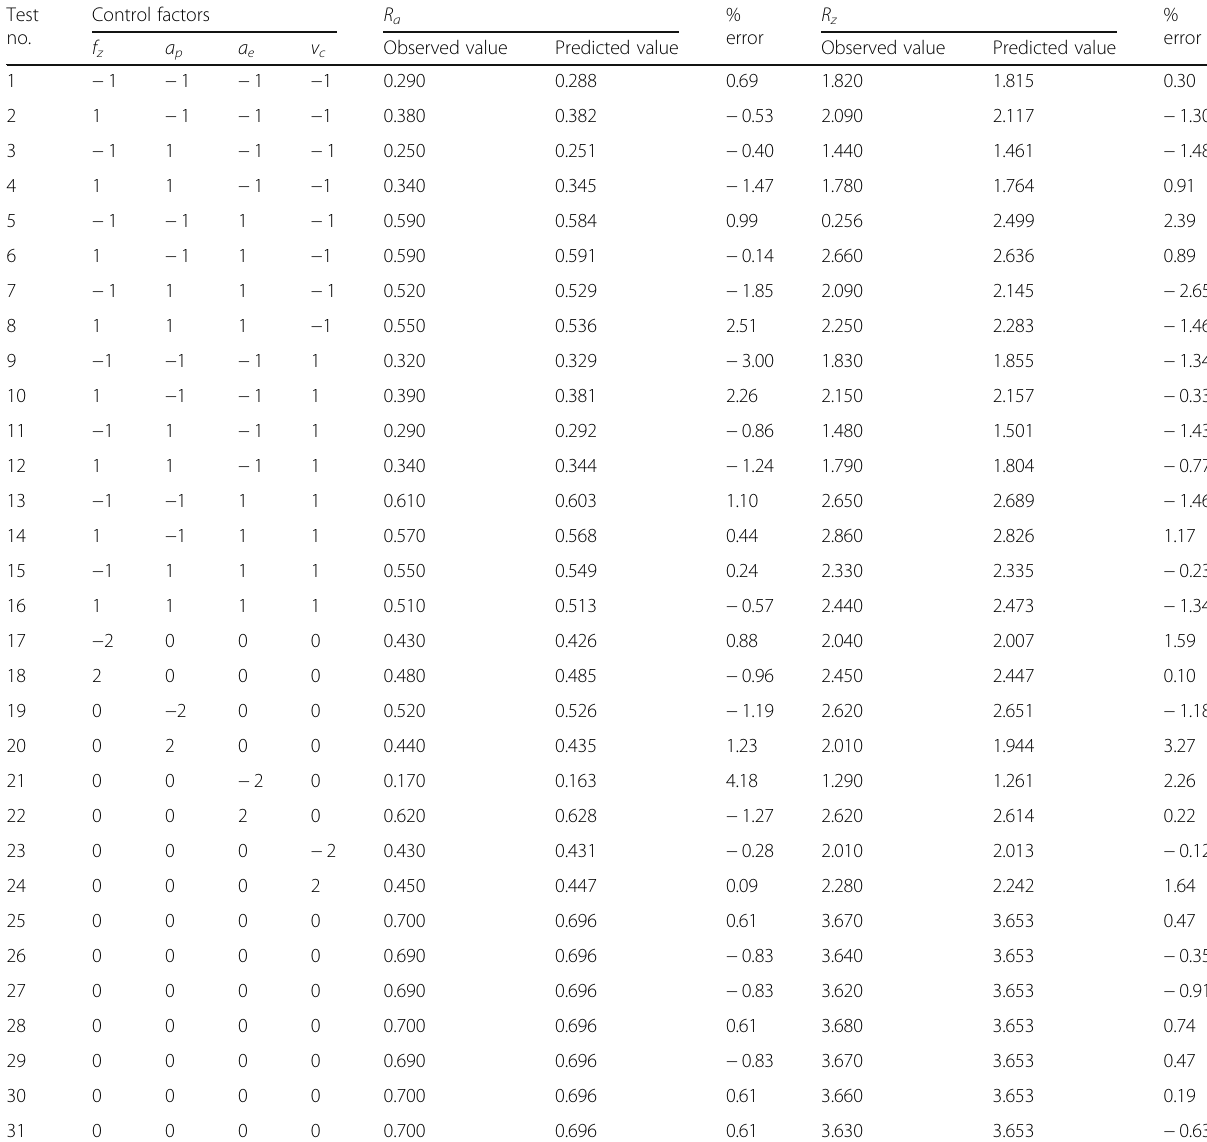
Table 3 Experimental design-CCD matrix in coded form and measured value of responses Test